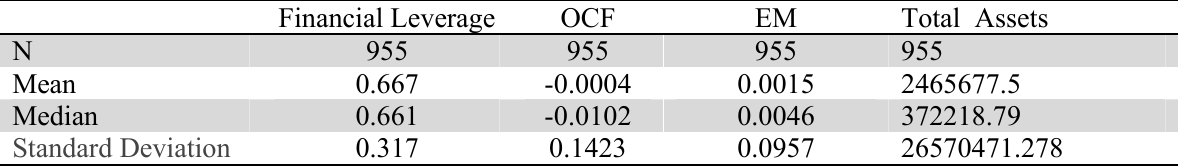
Descriptive Statistics